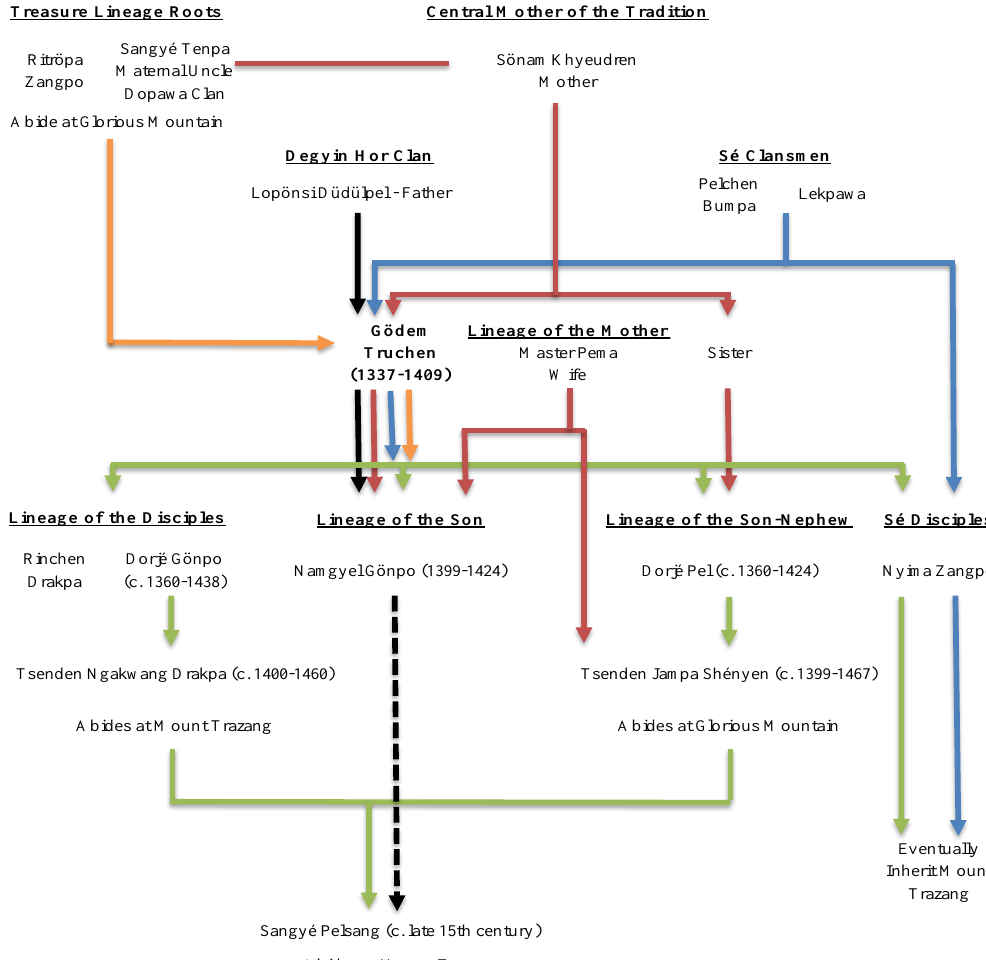
Table 2: The Early History of the Northern Treasure